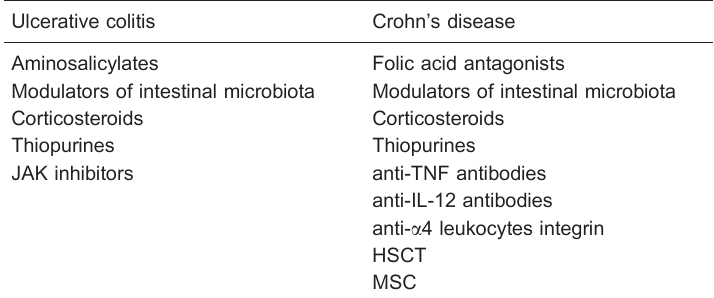
Table 1. Summary of the main classical and novel approaches for IBD